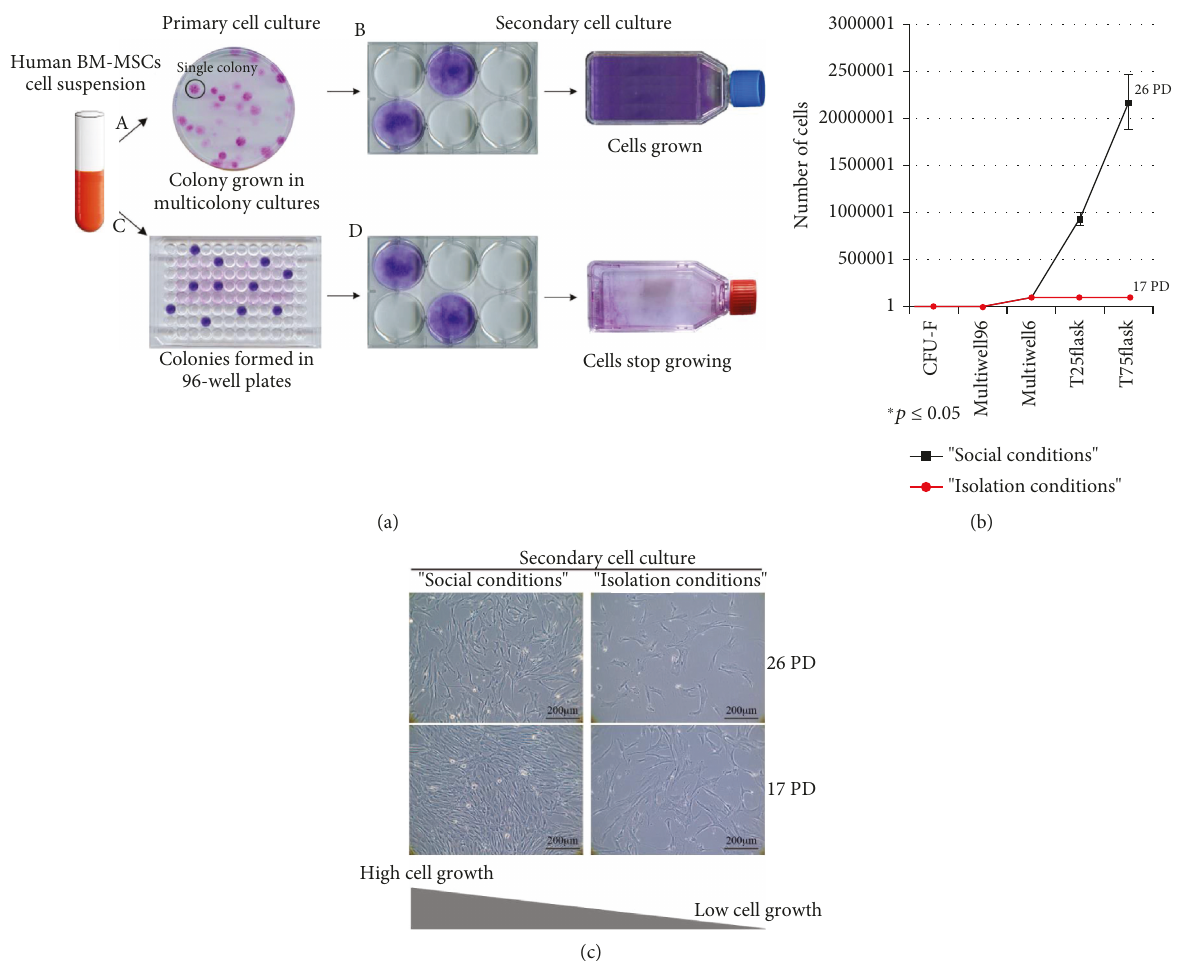
Figure 4: Clonal expansion depends on serum. (a) Samples of nucleated cells from primary BM-MSC cultures were plated and cultured either in 100mm dishes at 1.6 cells/cm 2 density or in 96-well plates at cloning dilution in FBS-supplemented culture medium. Colonies formed in 100mm dishes ( “ social ” conditions; A, B) could be further expanded. In contrast, colonies grown in 96-well plates at cloning dilution ( “ isolation ” conditions; C, D) could not be further expanded. (b) Proliferation curve of BM-derived clonal cell strain grown in social context (black diagram) or in “ isolation ” conditions (red diagram). Five individual colonies formed in 96-well plates and 5 from multicolony cultures were tested for PD. (c) Colonies grown in 96-well plates underwent a lower number of PD, 16 (T75 fl ask), after which the cells became senescent forming colonies identi fi able for their unusual, large and irregular shape compared to colonies grown in social context which could be further expanded to 22 PD (T75 fl ask). Images shown are representative results of secondary cell cultures expanded from colonies formed in social context or grown at cloning dilution. Results are expressed as the mean ± SD ( n = 5 ). ∗ p ≤ 0 05 . Scale bars represent 200 μ m as